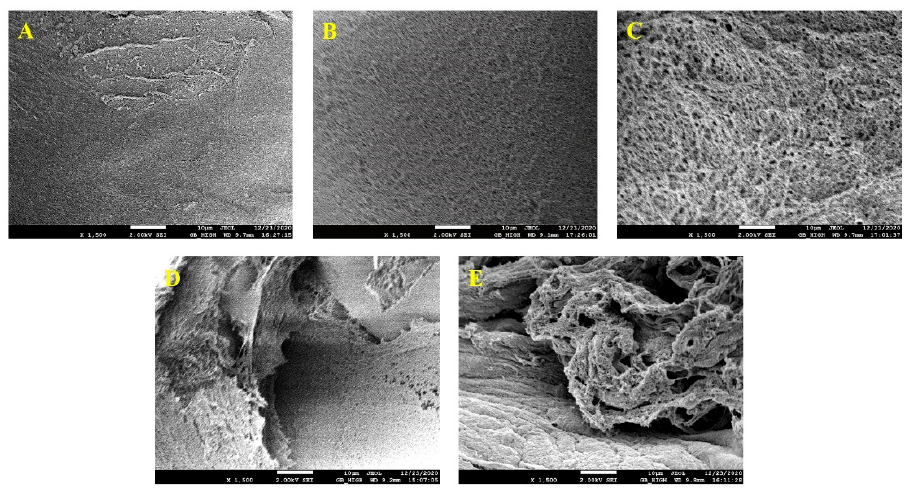
Figure 4. SEM images of ( A ) SA, ( B ) CCS/SA (1/3), ( C ) CCS/SA (2/3), ( D ) BCS/SA (1/3), ( E ), and BCS/SA (2/3) at a magnification of 1500×. The scale bar is 10 µm.